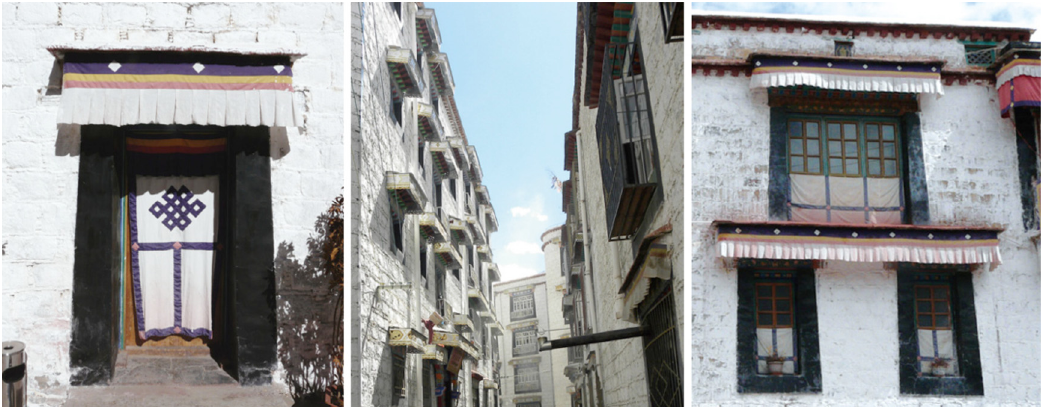
Fig. 3. Traditional dwellings sunshade in Tibetan-inhabited areas